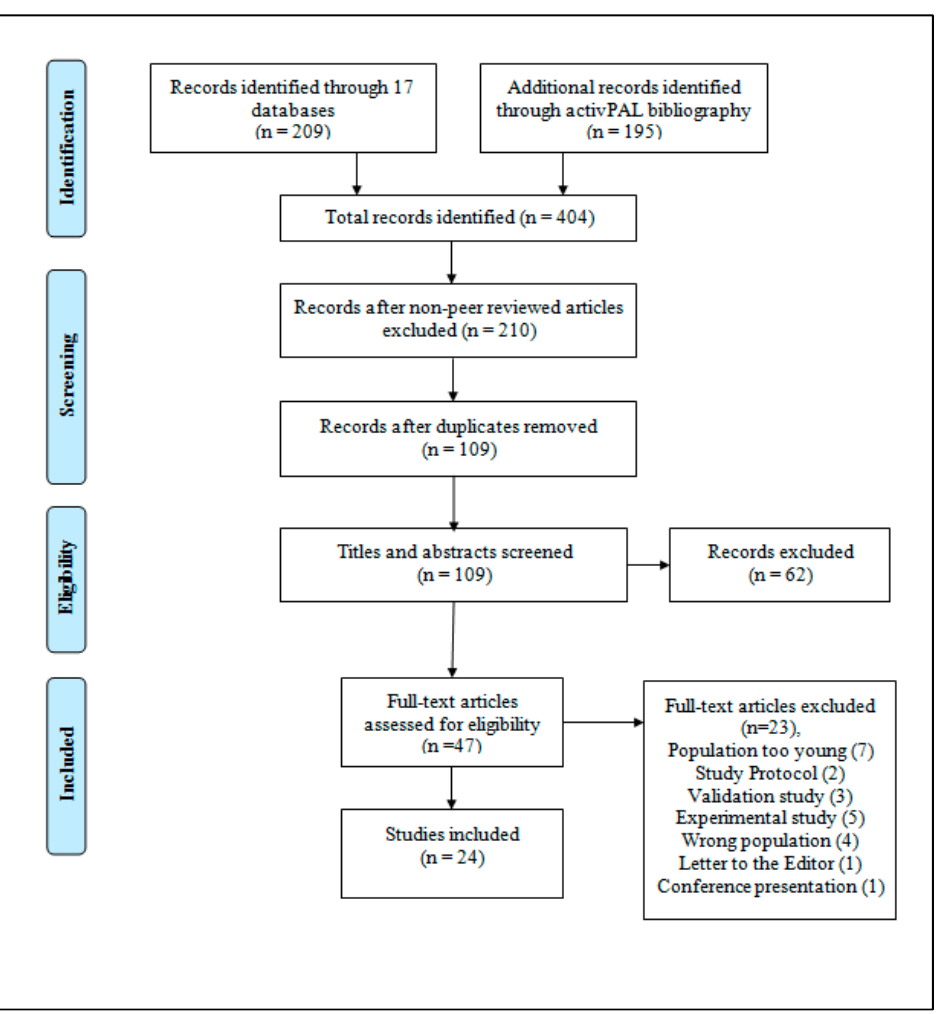
Figure 1. Study selection according to PRISMA guidelines.